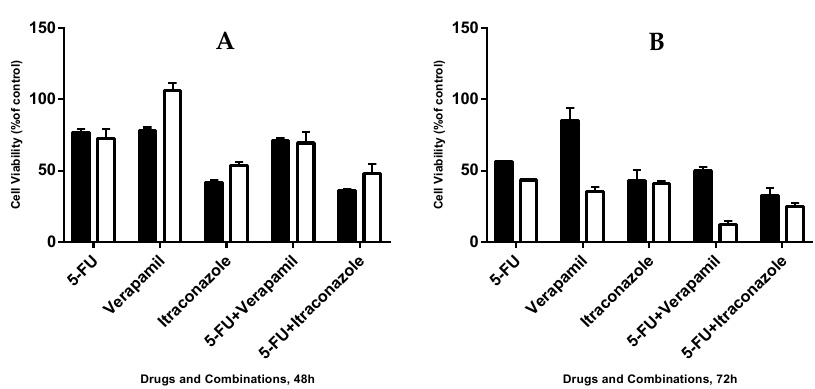
Figure 9. Effect of 5-FU, verapamil, itraconazole, and respective combinations of the last two drugs with 5-FU on the viability of MCF-7 cells, for 48 h ( A ) and 72 h ( B ). In the left, black bars, 5-FU was used in a concentration of 11.8 µ M and verapamil and itraconazole were used in a concentration of 55 and 3 µ M, respectively. In the right, white bars, all drugs were used in a concentration of 50 µ M. Each drug and drug combination were added in fresh medium, in sextaplicates. Results are presented as mean ± SEM, and represent the viability of cells (% of control) of 3–4 experiments. 3.8. Evaluation of the Transition from an Epithelial to a Mesenchymal Phenotype, in MCF-7 Cells Immunocytochemistry was used to assess the epithelial markers cytokeratins AE1/AE3 and E- cadherin, and the mesenchymal marker, vimentin, aiming at evaluating whether the resistant cells evolved from an epithelial to a mesenchymal state. MCF-7 cells were treated with 5-FU, verapamil, itraconazole, and the respective combinations of the last two drugs with 5-FU, acting on cells for a 48 h-period. 5- FU was used in a concentration of 11.8 μM and verapamil and itraconazole were used in a concentration of 55 and 3 μM, respectively. The obtained images are presented below (Figure 10). It was possible to observe that, in all conditions, the cells were positively stained for the epithelial markers, AE1/AE3 and E-cadherin, and negatively marked for the mesenchymal marker, vimentin. Other findings were the presence of fewer cells, damaged cells, cells with vacuoles and dead cells. These findings will be discussed in the next section.